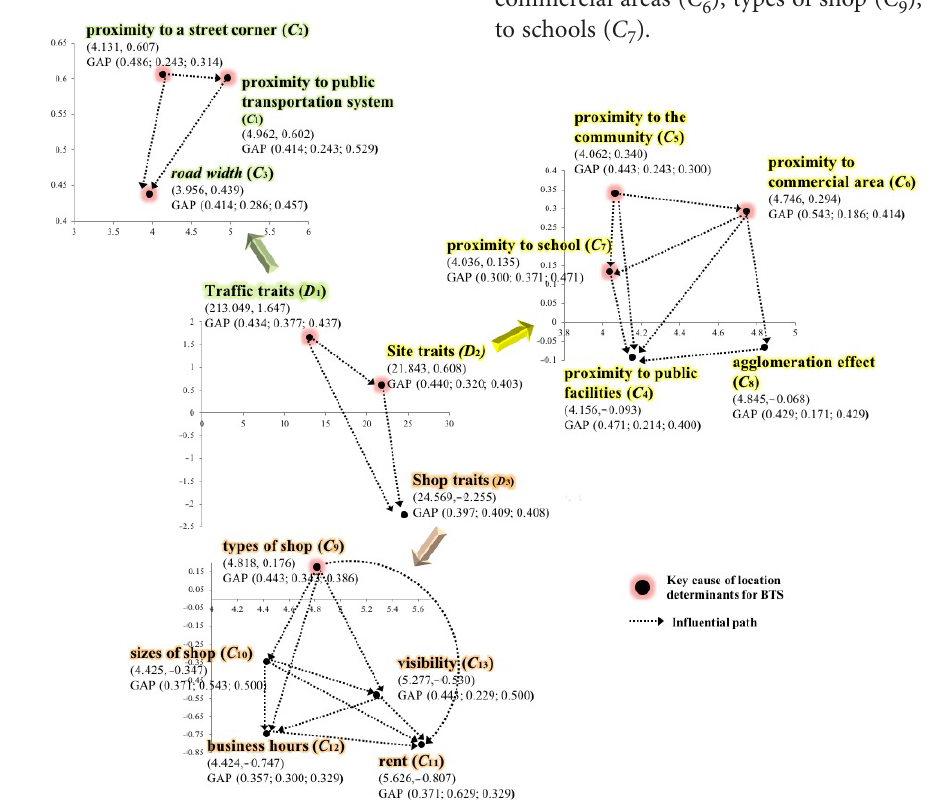
Figure 4. INRM to determine relationships between location determinants of